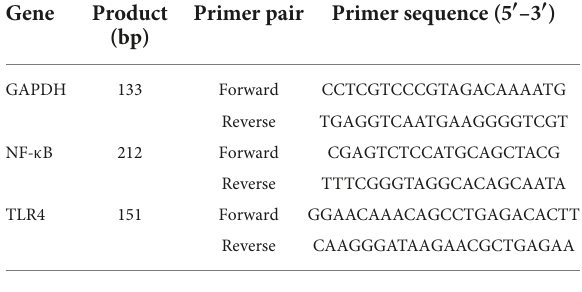
TABLE 1 The primer sequence for RT-qPCR.